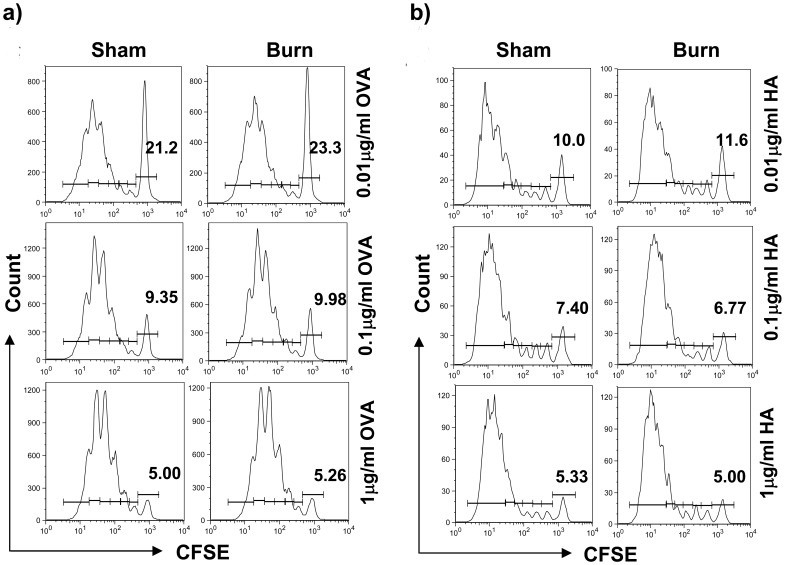
Burn injury had no impact on the ability of cDCs to stimulate Ag-specific T cell proliferation.Three days post-burn/sham injury, FACS-sorted cDCs were pulsed with either OVA323-229 class II or HA class I-restricted peptides (concentration ranging from 0.01 to 1 µg/ml) and activated with CpG (6 µg/ml, 18–20 hr). DCs were then washed and subsequently co-cultured with CFSE-labeled CD4+ and CD8+ T cells for three consecutive days. Proliferation of (a) CD4+ and (b) CD8+ TCR-transgenic T cells is illustrated by means of CFSE dilution measured using flow cytometry. Representative FACS plots with percentages of unproliferated cells are shown (n = 9, 3 independent experiments).